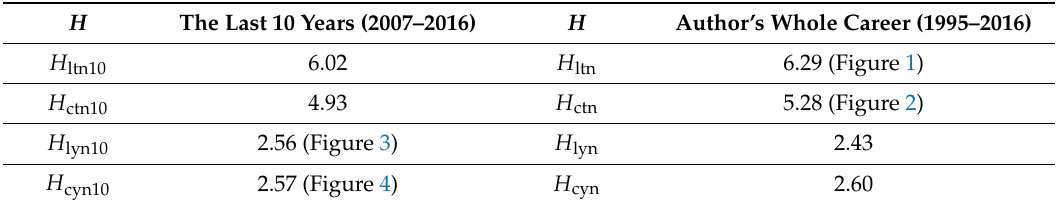
Table 3. The estimated values of the H indexes per author for the first analyzed PH (Table A1). All values are for the net production or productivity (i.e., after removal of reciprocal citations). Abbreviations: c = cubic fitting; l = linear fitting; n = net number of citations; t = total articles; y = citations are divided by the number of years since